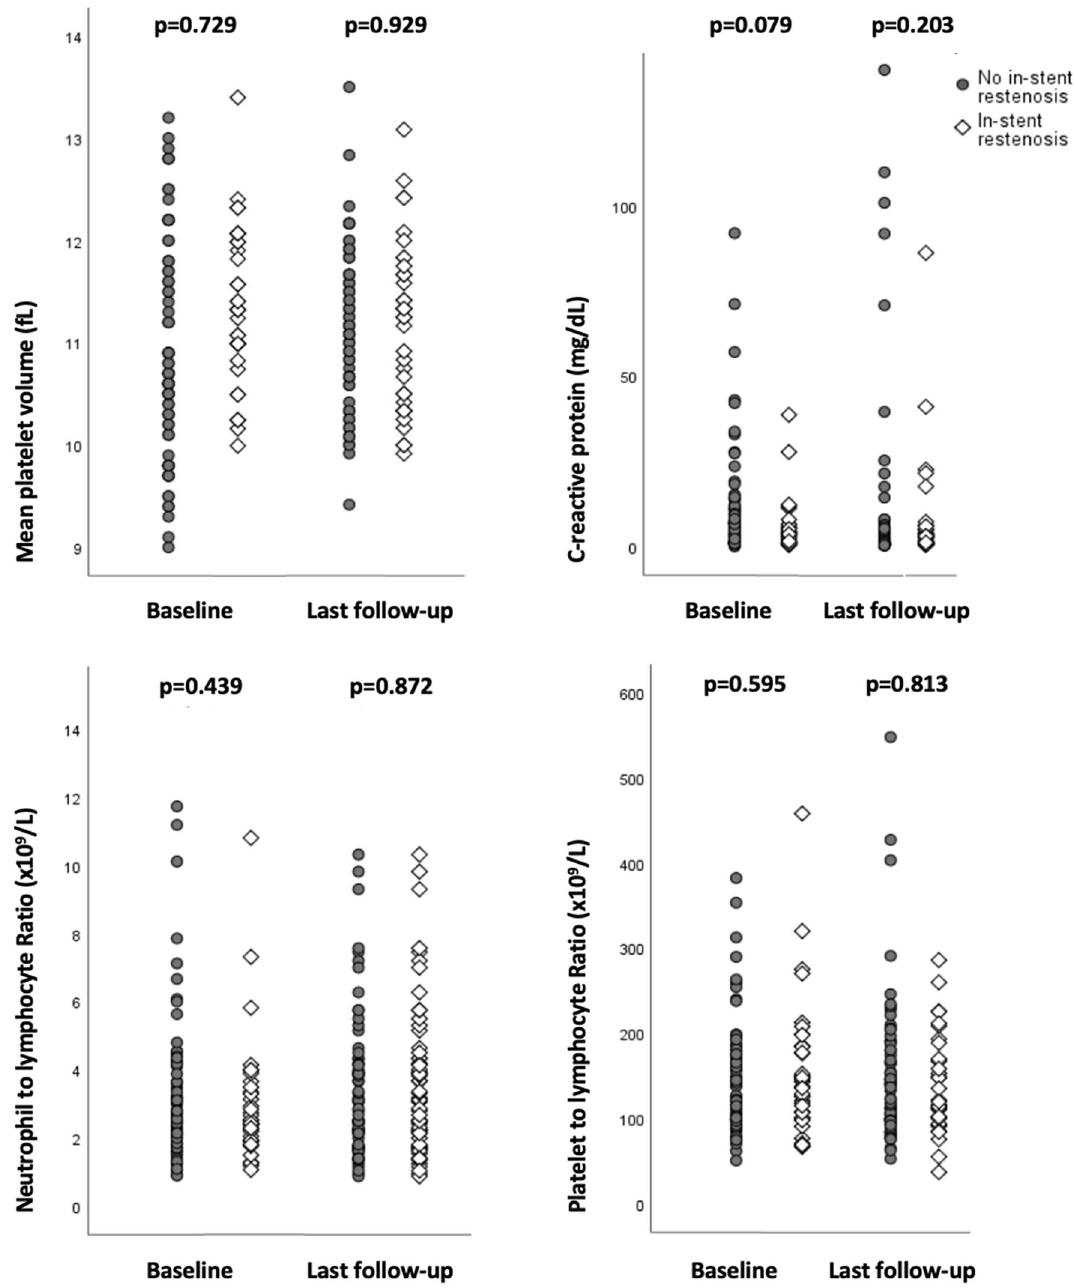
Figure 2. Blood biomarkers of platelet aggregation and inflammation in ISR and non-ISR patients after stenting of intracranial artery